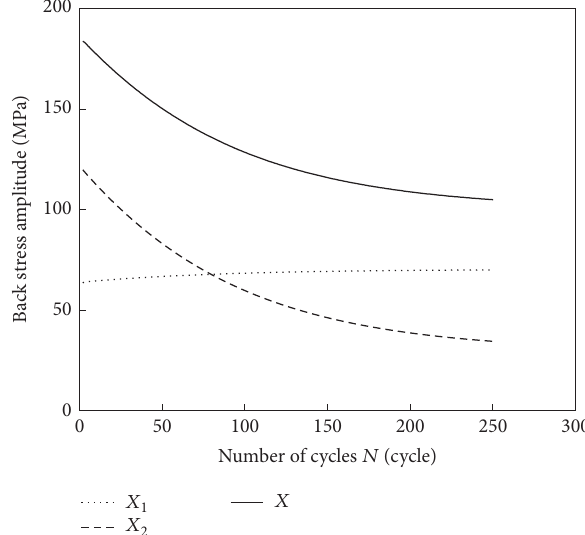
Figure 9: Number of cycle effects at various strain rates on stress amplitude for a modified 9Cr-1Mo steel. Figure 10: Number of cycle effects on back stress amplitude for a modified 9Cr-1Mo